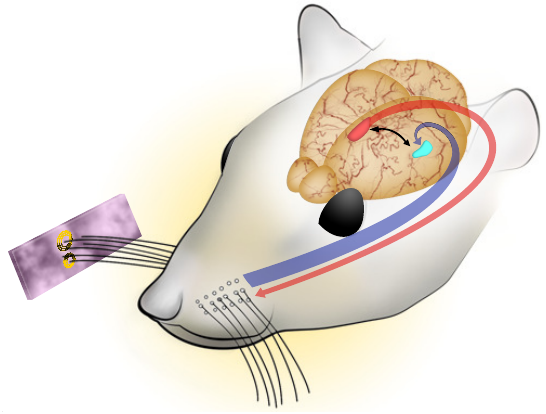
Figure 1. Rodents and vertebrate animals sense the environment by moving or whisking their whiskers rhythmically across nearby surfaces. Whisking excites several hundred primary afferent fibers which innervate mechanoreceptors on each whisker shaft [21]. These signals then reach the brain traveling via sensory nerve afferents